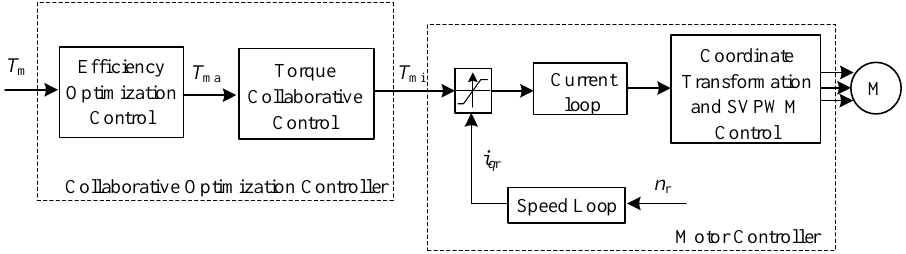
Figure 6. The overall structure diagram of the electric vehicle motor drive system.